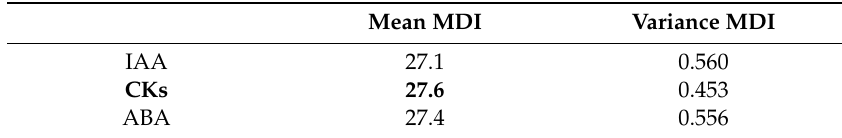
Table A1. Random forest classification for root data. Mean decrease in impurity as a measure of significance for roots.